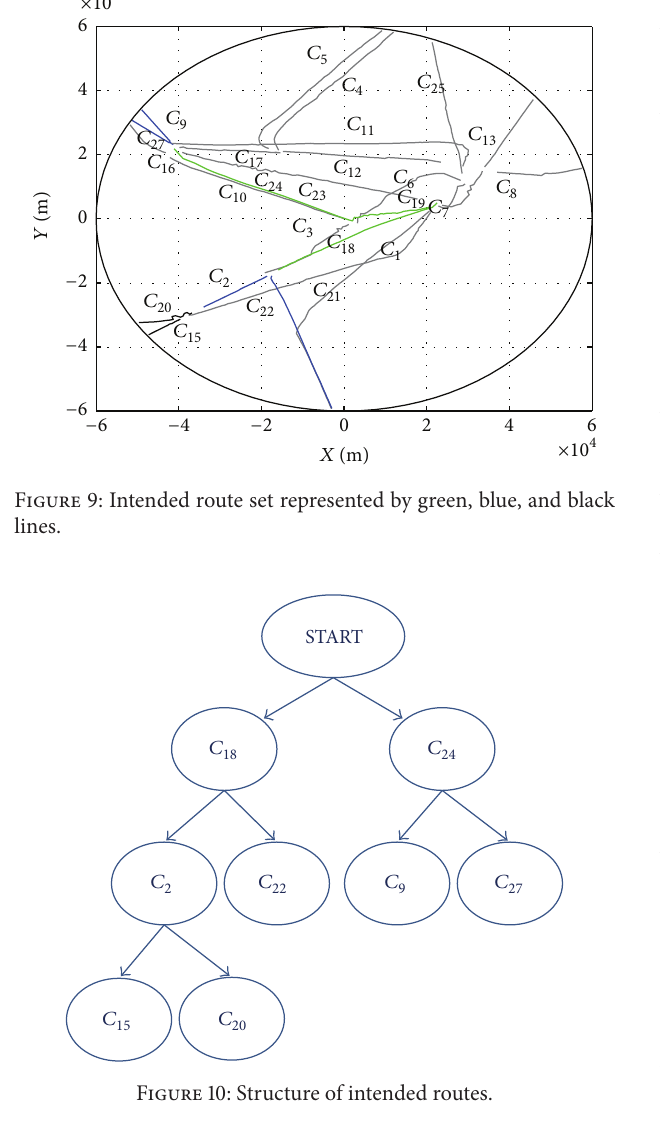
Table 2: Inference accuracy of AII approach in three different cases.